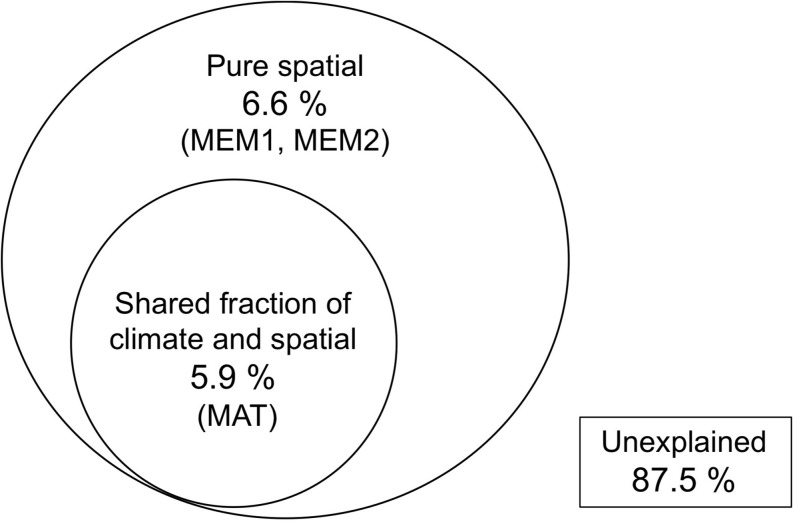
Venn diagram showing pure and shared effects of spatial distance and climate on fungal assemblage composition as derived from variation partitioning analysis. Selected variables are in parentheses. No variables were selected in the leaf property model, i.e. the proportion of explained variation was zero.